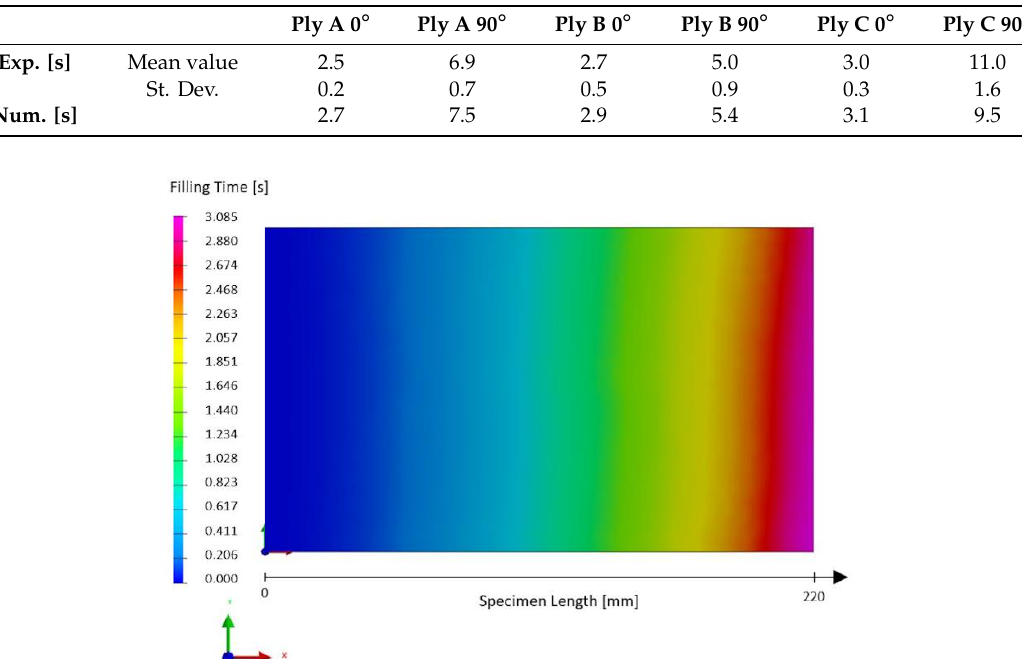
Table 8. Carbon textile reinforcement permeability experimental and numerical filling time results.